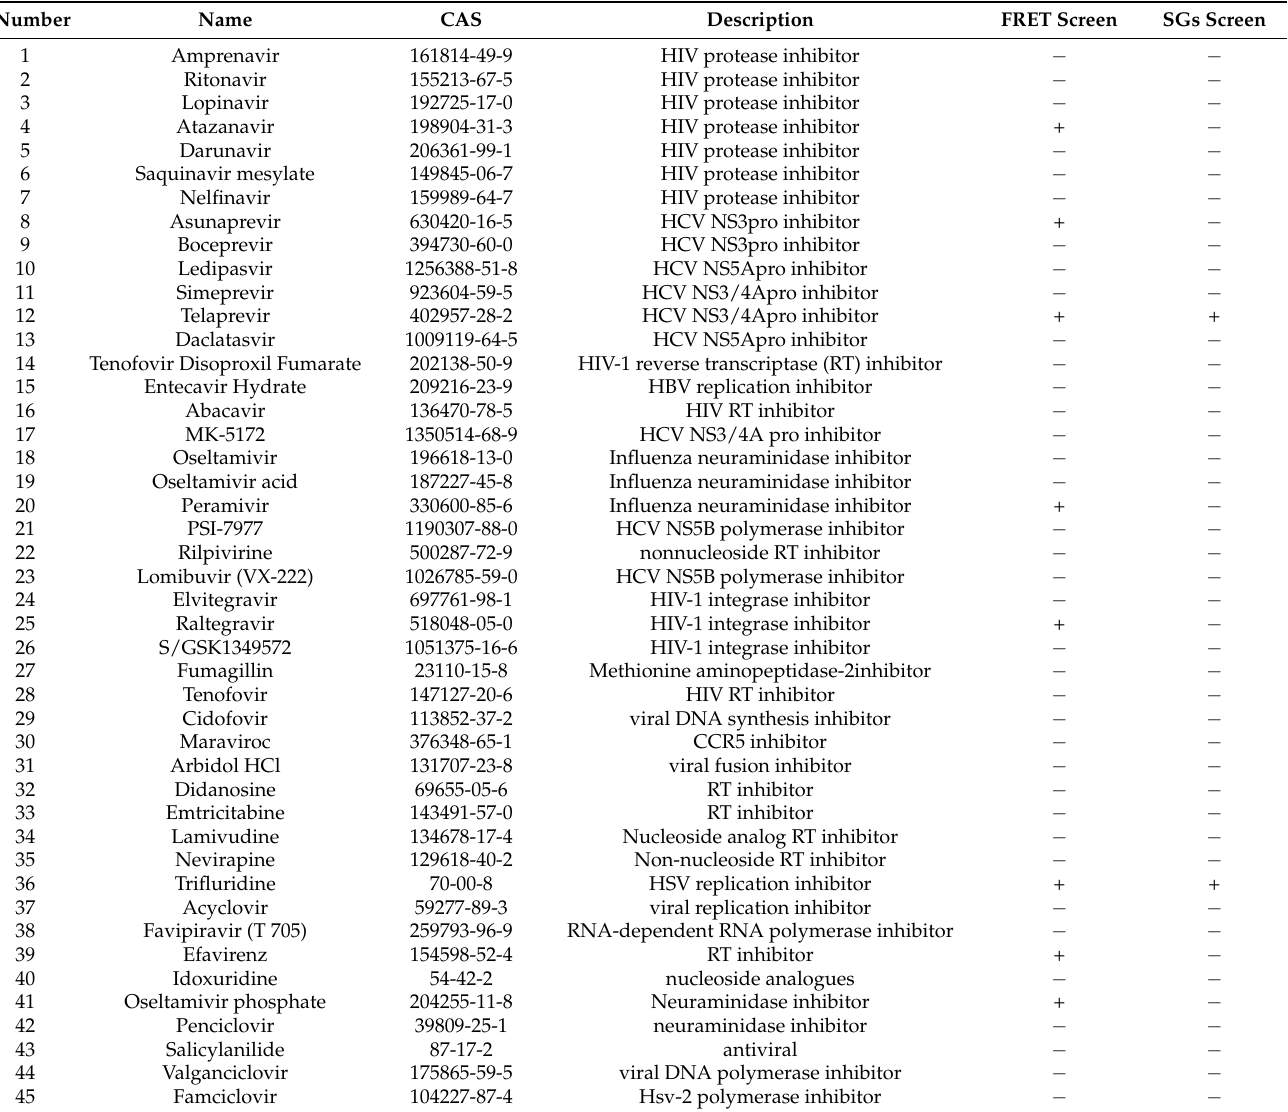
Table 1. FDA-approved antiviral compound used in this study and summary of the screening